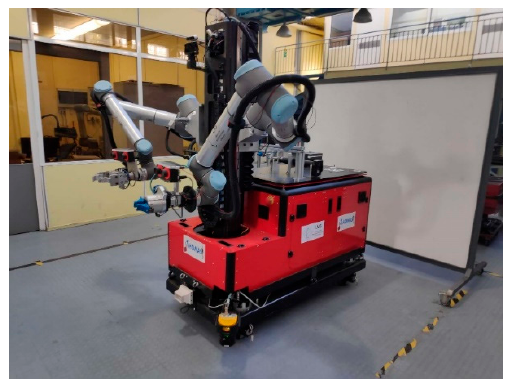
Figure 1. Mobile dual-arm worker .